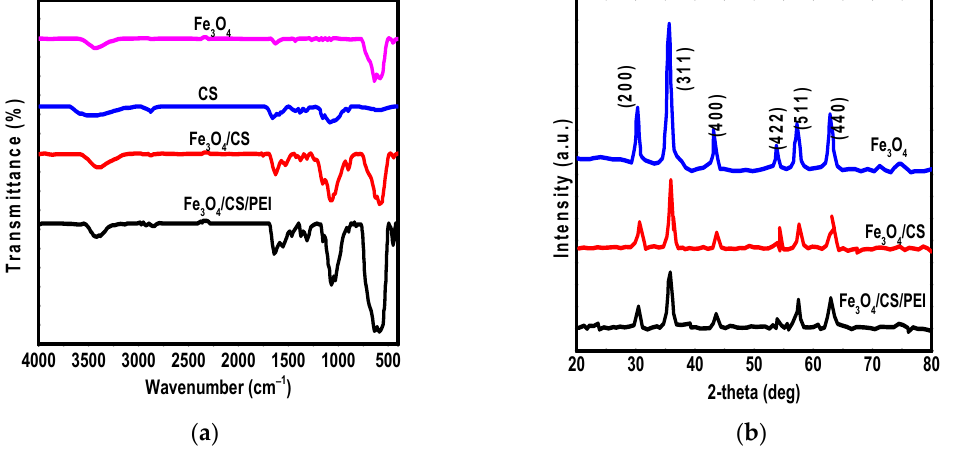
Figure 1. FT-IR ( a ) and XRD ( b ) of the synthesized Fe 3 O 4 , Fe 3 O 4 /CS, and Fe 3 O 4 /CS/PEI magnetic nanomaterials.